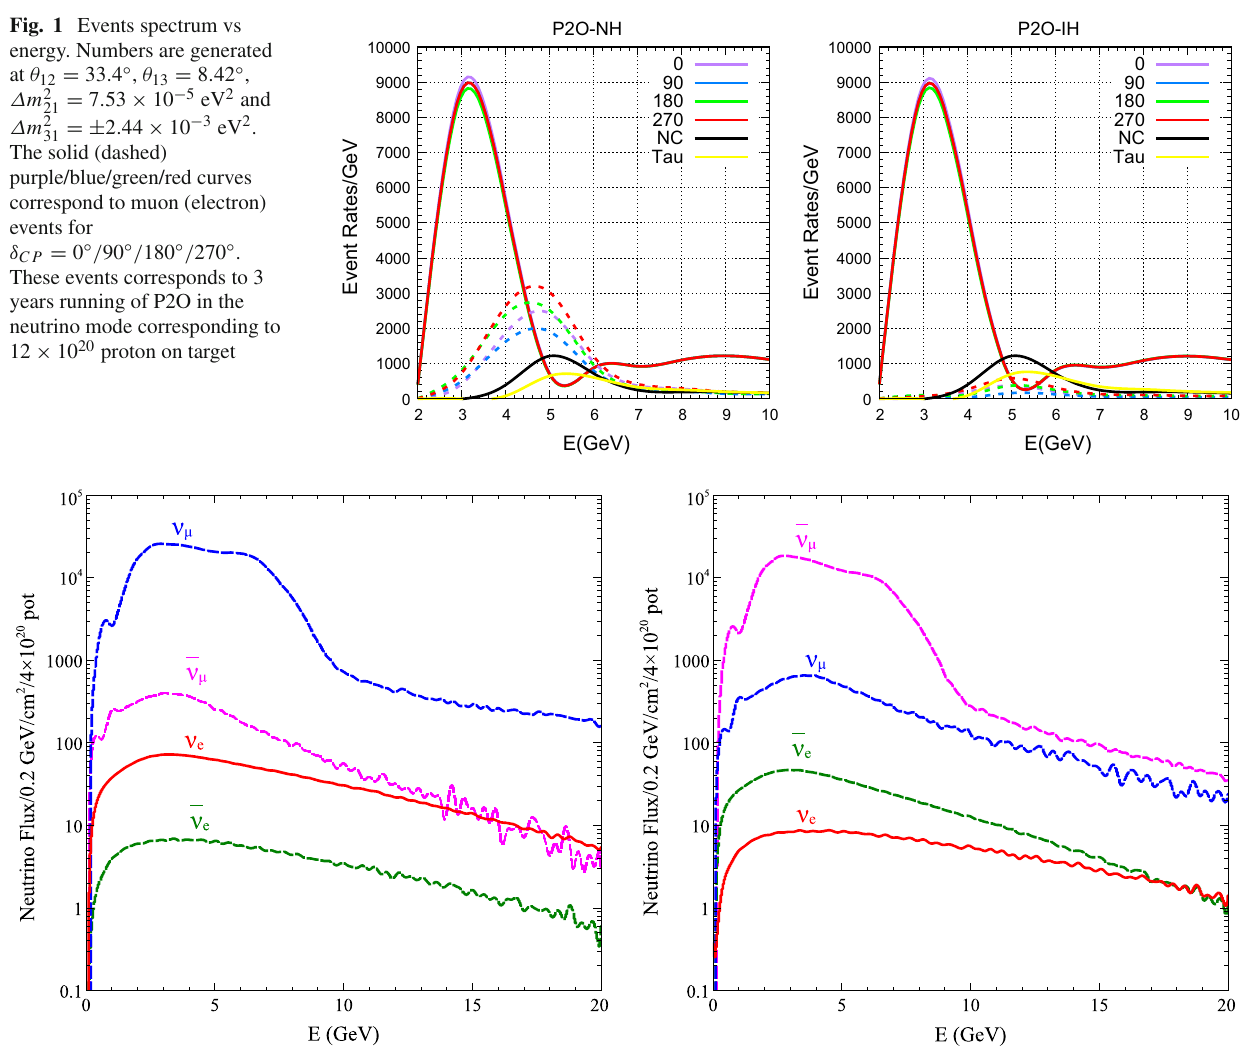
Fig. 2 Fluxes as a function of energy. The left panel is for neutrino flux and the right panel is for antineutrino